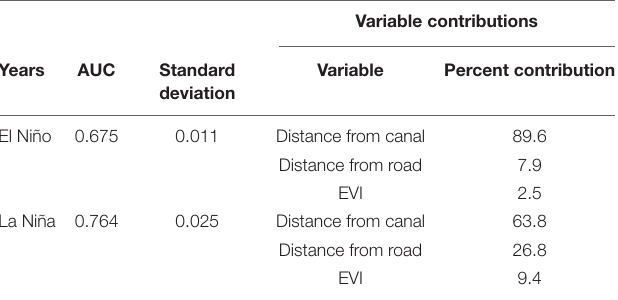
TABLE 4 | Area under the curve (AUC) values, standard deviation and percent contribution of each environmental variables for the probability of fire presence in PSWR and surrounding landscape during El Niño and La Niña years from 2001 to 2020 using the Maximum Entropy